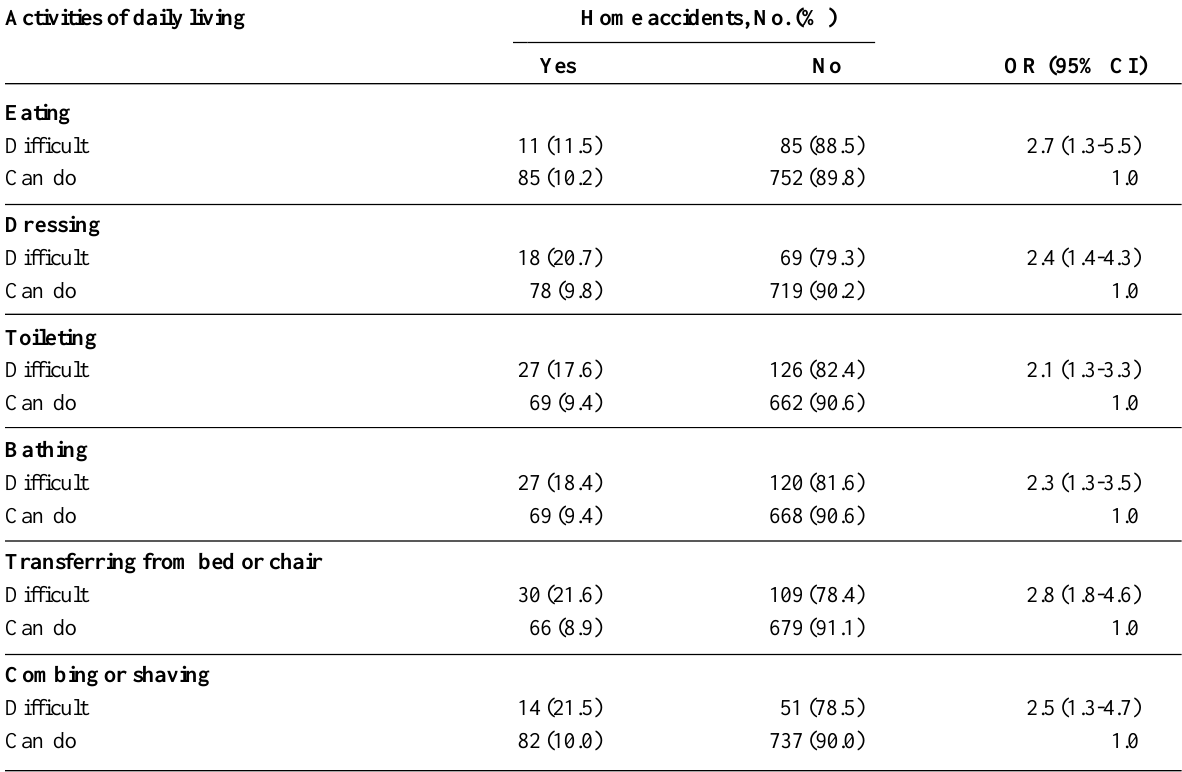
Table 2. Activities of daily living and the occurrence of home accidents Activities of daily living